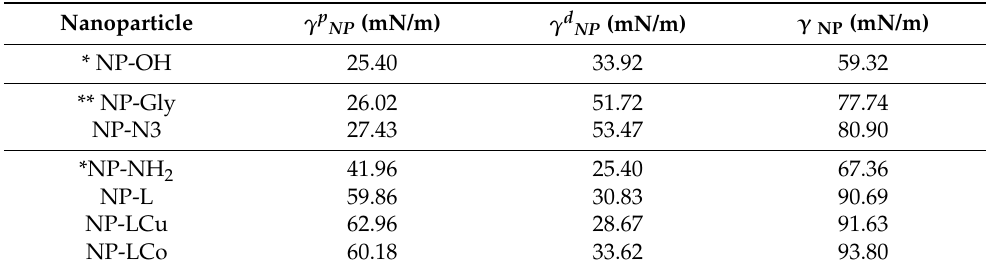
Table 2. Surface energies γ d